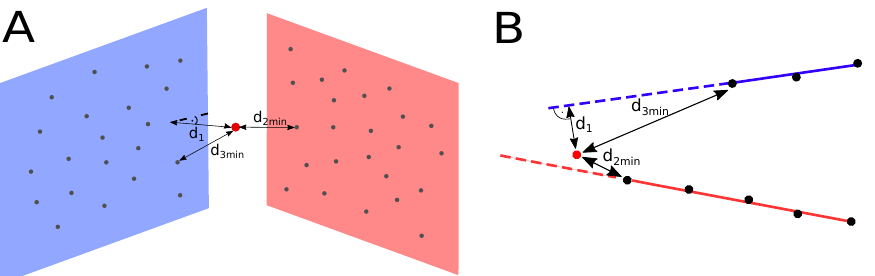
Figure 6. Distance to the closest plane ( d 1 ), distance to the closest point ( d 2 ), and the distance to the second closest feature ( d 3 ), which are considered during the process of addition of a point to the existing planar ( A ) and linear ( B ) features.